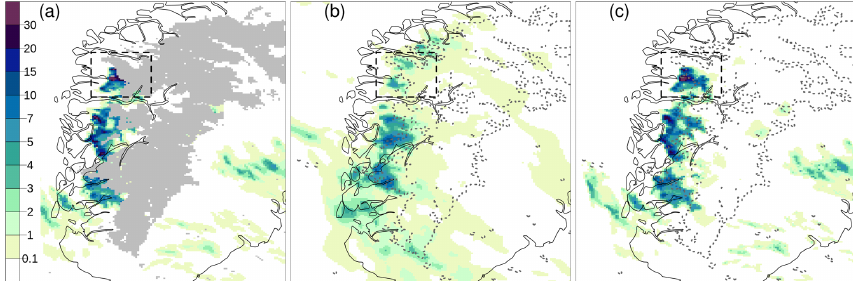
Figure 9. Hourly precipitation totals for 30 July 2019, 15:00UTC (mmh − 1 ), over South Norway (see Fig. 7). Observations are shown in (a) over the same grid as the analysis. For each grid cell, the average of the observed values within the cell is shown. Grid points that are not covered by observations are marked in gray in (a) , and the dashed gray lines in (b) and (c) delineate the boundary of the gray area shown in (a) . The background ensemble mean is shown in (b) . The analysis expected value is shown in (c) . The color scale is the same for all panels. The Sogn og Fjordane domain of Fig. 7 is shown as the dashed box.